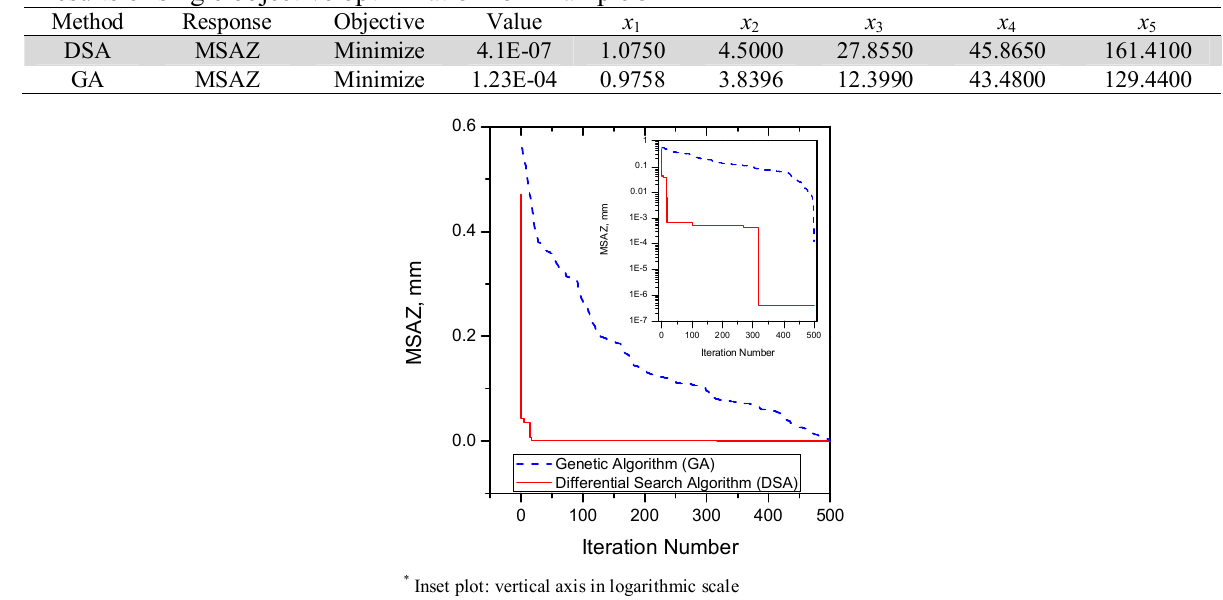
Fig. 5. Convergence diagrams of DSA and GA for Example